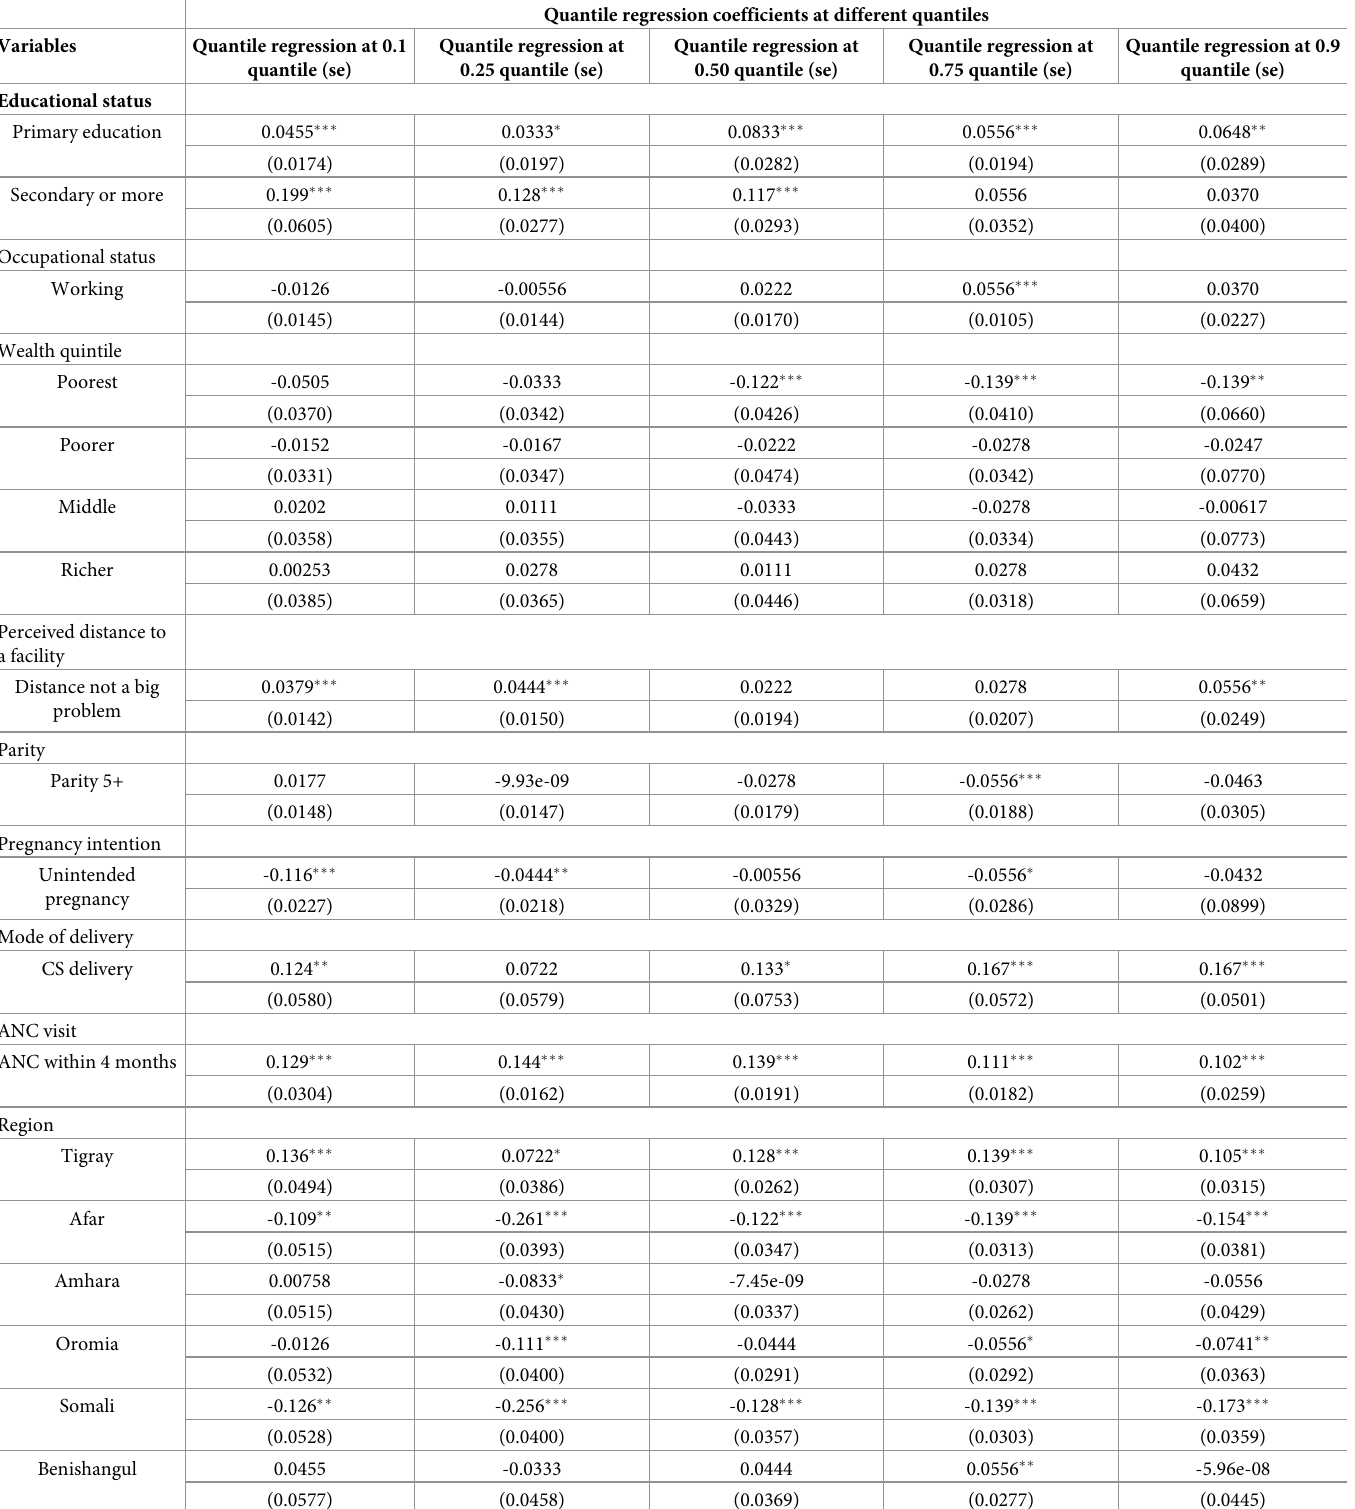
Table 3. The results of the multivariable quantile regression